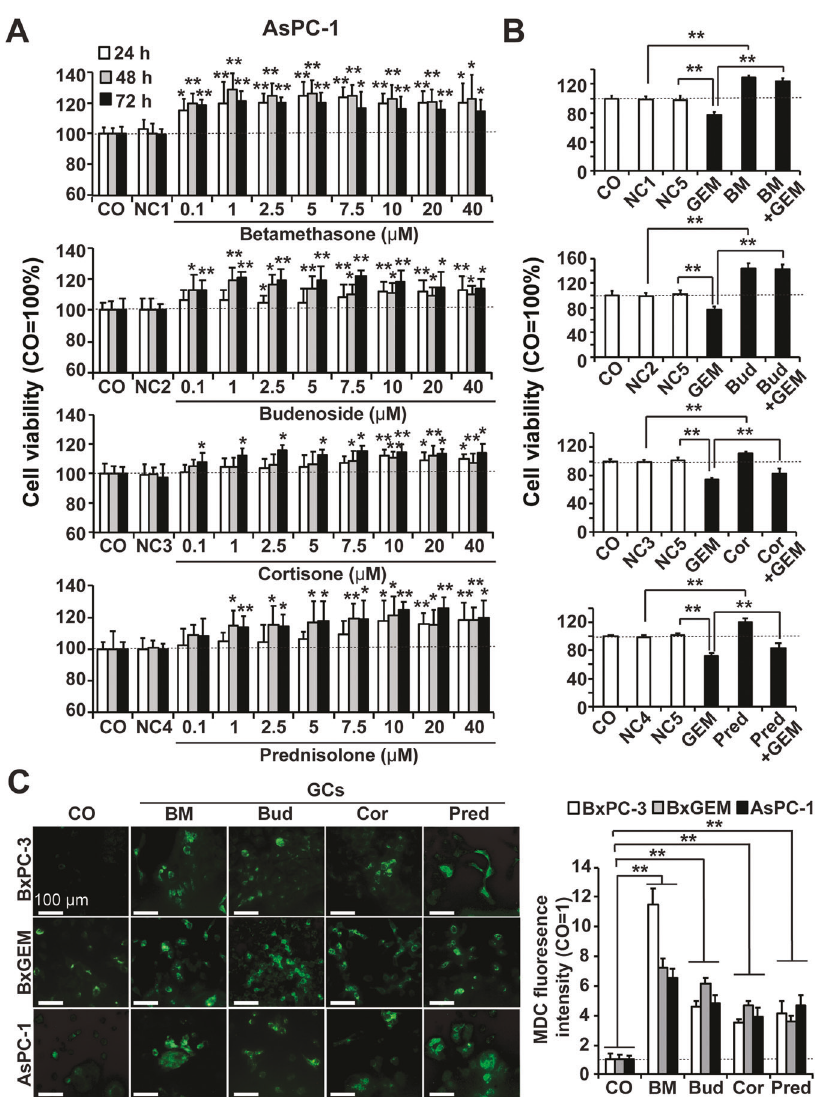
Fig. 4 Various GCs enhance viability and induce gemcitabine resistance and autophagosome formation. A AsPC-1 cells were treated with the GCs betamethasone, budesonide, cortisone, and prednisone at the concentrations indicated or with vehicle controls alone (NC1: DMSO 1:50,000; NC2: DMSO: 1:100,000; NC3: methanol: 1:25,000; NC4: DMSO: 1:100,000), followed by MTT assay 24, 48 and 72 h later. The controls of each timepoint were set to 100%. * P < 0.05, ** P < 0.01 compared to the negative control (NC). B AsPC-1 cells were cultured in medium containing 1 µM betamethasone (BM), 1 µM budesonide (Bud), 10 µM cortisone (Cor), or 10 µM prednisone (Pred) or were treated with vehicle alone as described above (NC5: PBS: 1:126,000) or were left untreated (CO). Then, 48 h later, 50 nM gemcitabine (GEM) was added to untreated and GC-treated cells as indicated for another 48 h. The viability was measured by MTT assay. The percentage of viable cells in the control groups was set to 100%. * P < 0.05, ** P < 0.01. C MDC staining of acidic vacuoles: BxPC-3, BxGEM and AsPC-1 cells were cultured in the presence of different GCs as indicated above for 24 h or were left untreated (CO). The cells were labeled with MDC (green) followed by immediate monitoring under a fl uorescence microscope at 200× magni fi cation. The MDC fl uorescence intensity was evaluated by ImageJ, and the density in the control was set to 1. The control line is marked by a black dotted line. The means with standard deviations are shown. * P < 0.05, ** P < 0.01 compared to the control